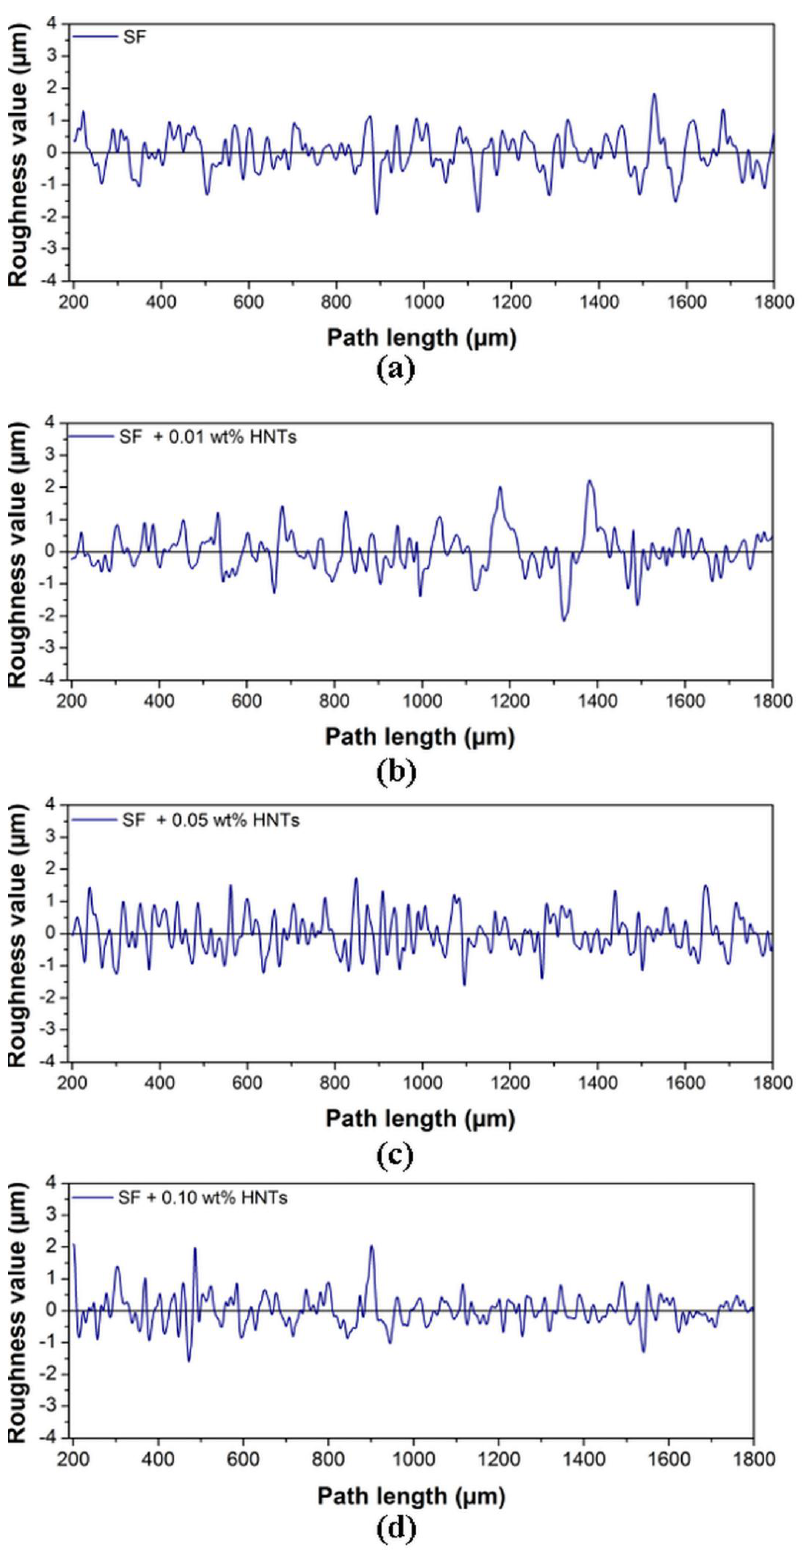
Figure 10. Roughness profiles and Ra values of worn blocks for SF + HNT nanofluidos: ( a ) SF; ( b ) SF + 0.01 wt. % HNTs; ( c ) SF + 0.05 wt. % HNTs; ( d ) SF + 0.10 wt. % HNTs. Arrows indicate the direction of